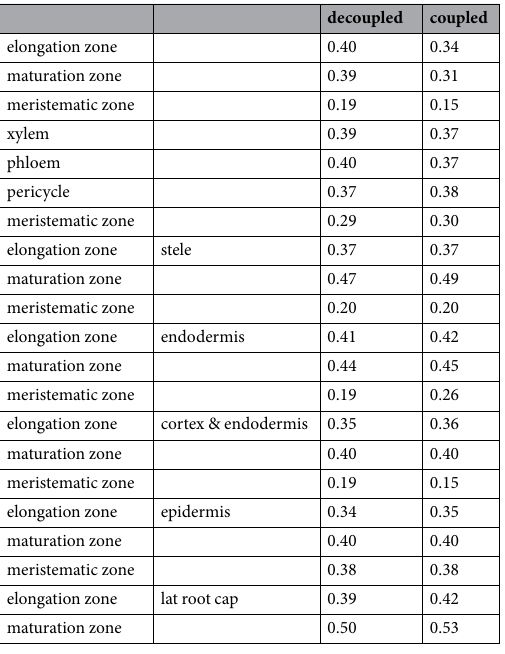
Table 1. Concordance of flux distributions and the transcriptomics data. For all three scenario Birnbaum, Li 1 and Li 2 the flux distributions are compared with the respective transcriptomics data by determining the Pearson correlation coefficient. All presented correlations were significant at level